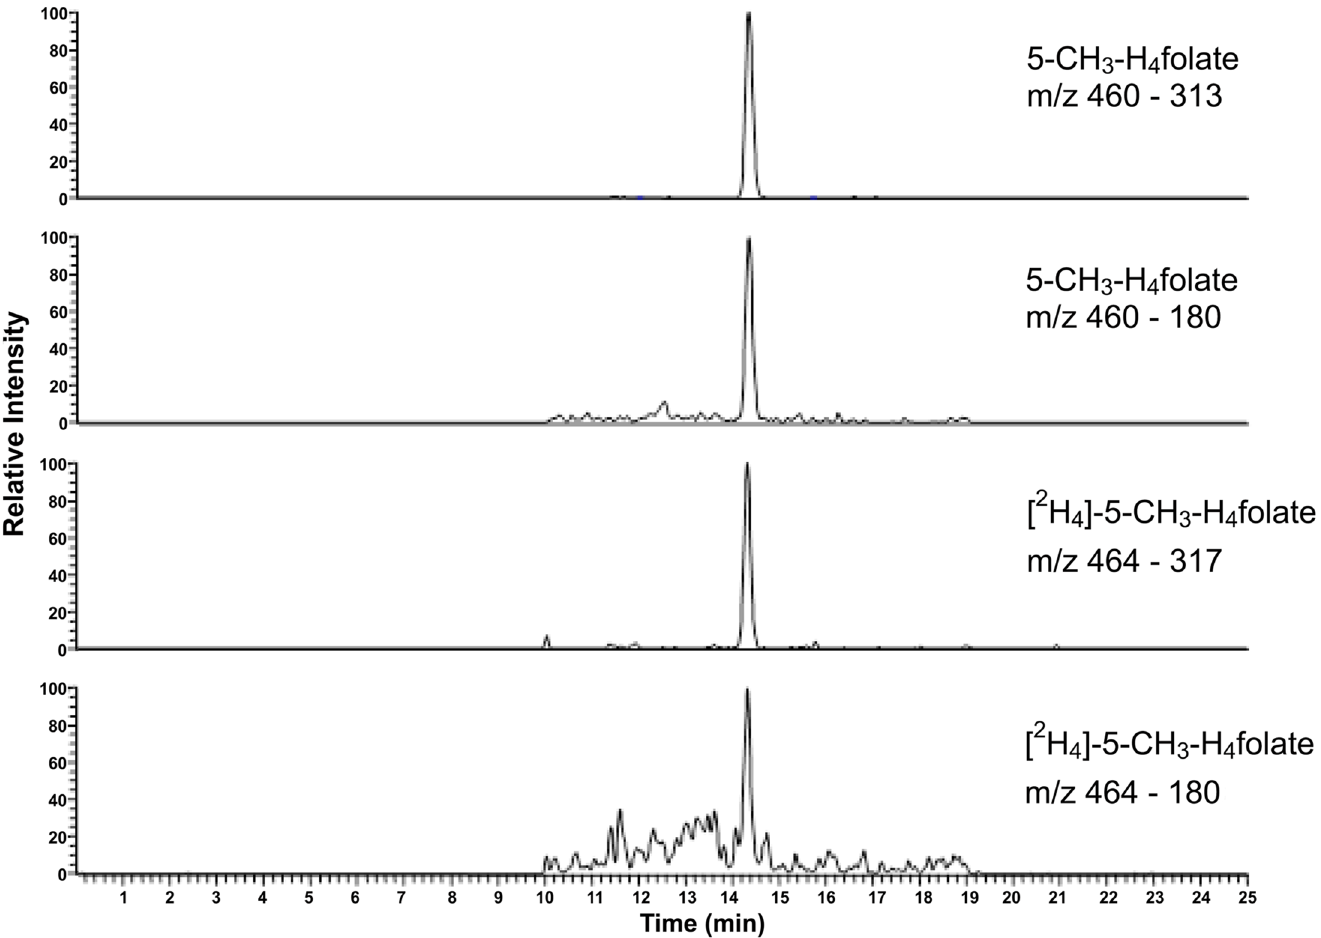
Fig 4. Liquid chromatography – tandem mass spectrometry chromatogram in the multiple-reaction monitoring mode for the dried blood